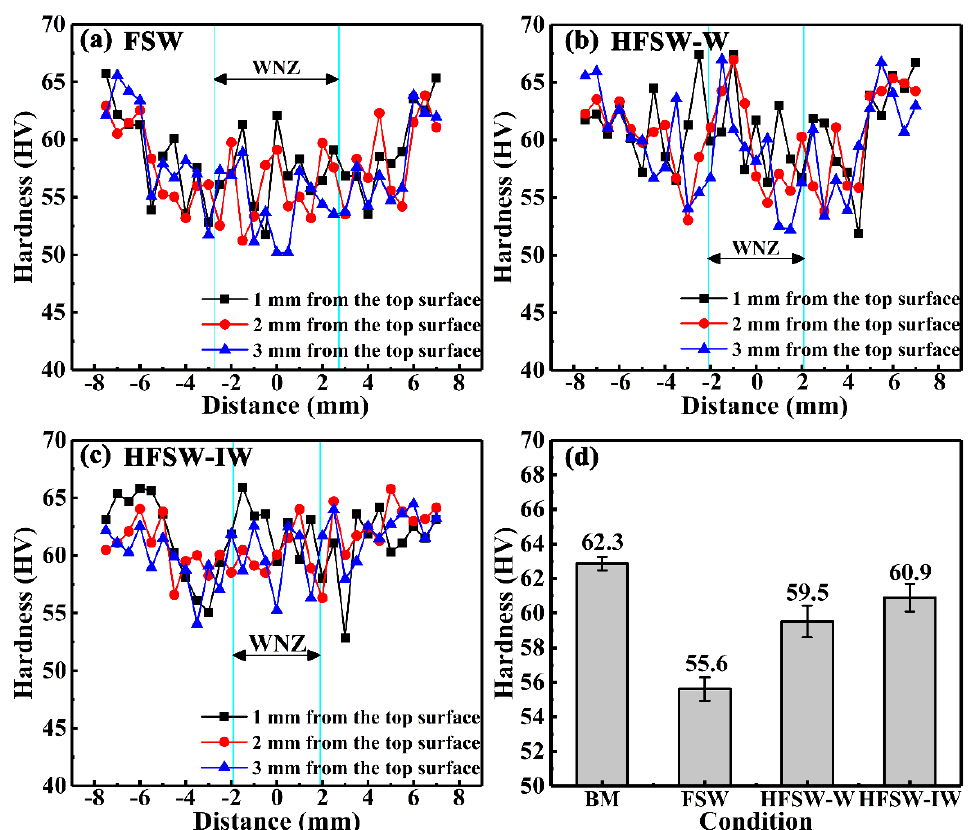
Figure 9. The hardness of the joints under: ( a ) the FSW condition, ( b ) the HFSW-W condition and ( c ) the HFSW-IW condition. ( d ) is the average value of hardness measured in WNZ under each condition and the mean value of base metal (abbreviated as BM in figure ( d )).